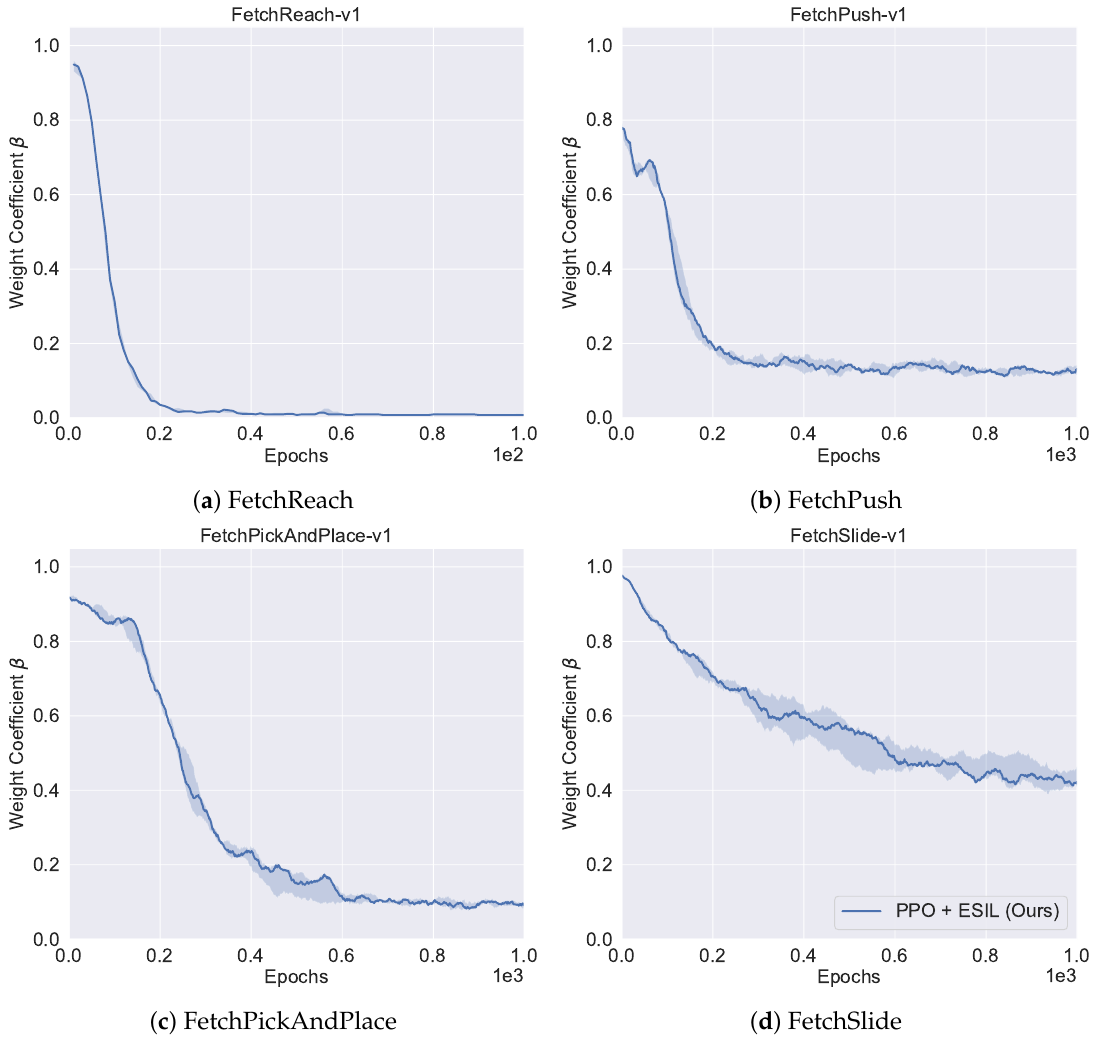
Figure 7. Variation in adaptive weight coefficient β through the training on all Fetch